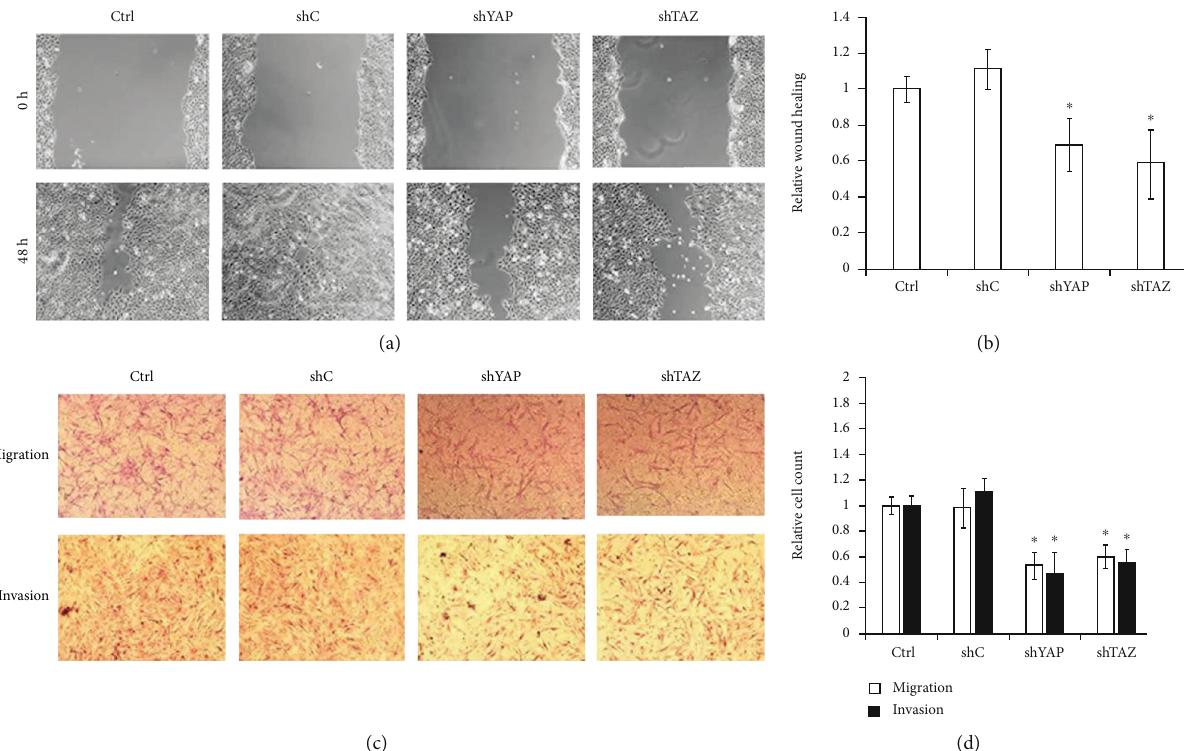
Figure 3: Knockdown of YAP or TAZ attenuated the migration and invasion of RA-FLS. (a, c) Migration and invasion of stable YAP or TAZ knockdown RA-FLS and their corresponding control cells (shC) and null (Ctrl) were determined by wound healing assays (a) and Transwell assays (c), respectively. Representative images of three independent experiments are shown. Magni fi cation, × 100. (b, d) Quanti fi cation of relative numbers of migrated and invaded cells in fi ve randomly fi elds for each replicate was shown. All experiments were performed independently three times, and data were shown as mean ± SD . ∗ P < 0 : 05 relative to shC by Student ’ s t -test.